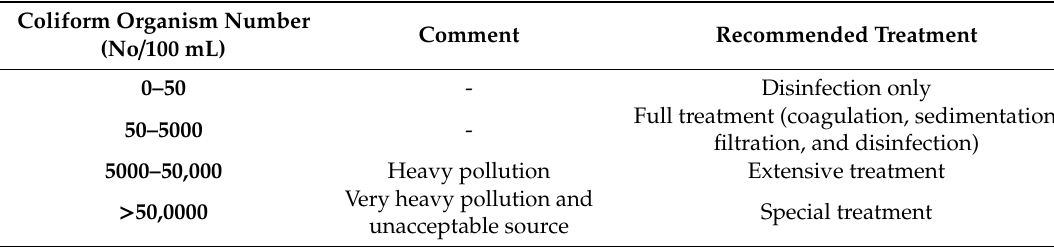
Table 13. Guideline for raw water treatment [24,54].